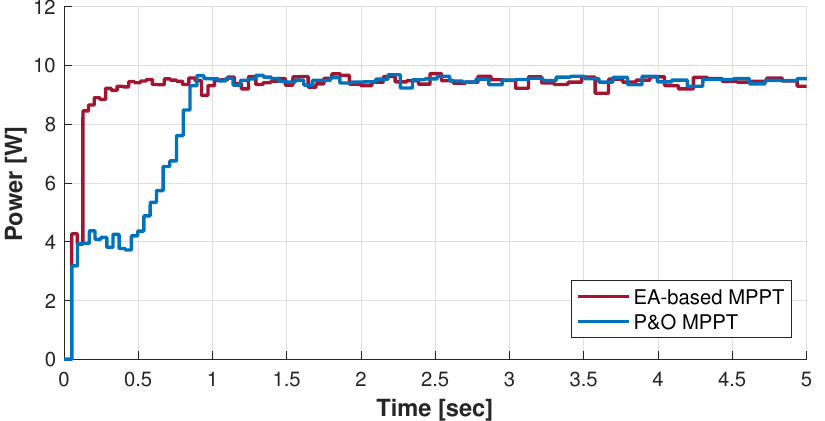
Figure 33. Experimental performance of the MPPT algorithms, comparing the EA-based MPPT and P&O algorithms.